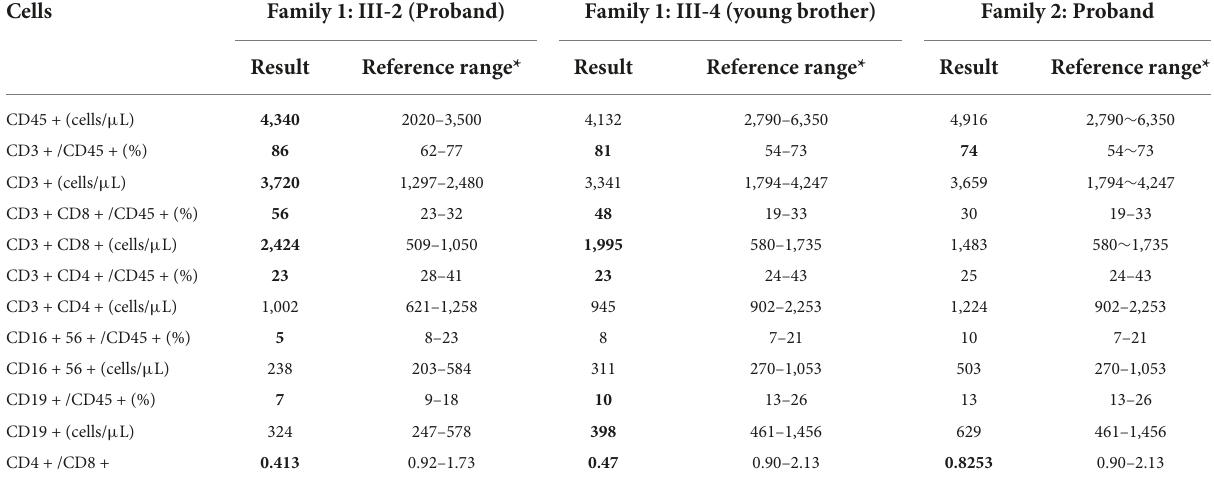
TABLE 2 T. B. NK lymphocyte immunophenotype of the patients of this study.